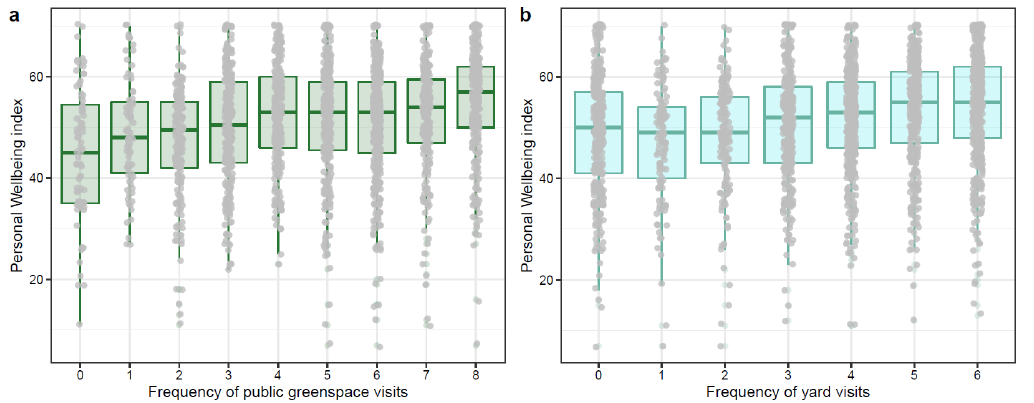
Figure 1. Differences in personal wellbeing based on the frequency of public green space and yard visit: People who visit public green space more often ( a ) or visit the yard more often ( b ) were more likely to have better personal wellbeing. Grey points are raw data points. In ( a ), 0 = never, 1 = once a year, 2 = once every three months, 3 = once a month, 4 = 2 – 3 times a month, 5 = once a week, 6 = 2 – 3 days a week, 7 = 3 – 5 days a week, and 8 = 6 – 7 days a week. In ( b ), 0 = without access to yard or never, 1 = less than once a month, 2 = 2 – 3 times a month, 3 = once a week, 4 = 2 – 3 days a week, 5 = 4 – 5 days a week, and 6 = 6 – 7 days a week. Additional analysis was run excluding individuals with- out access to a yard (Supplementary Table S2). 3.2. Green Space Use over the Year and Reported Change in Wellbeing We analysed the change in status wellbeing and health to better understand how changes in green space use were related to an increased likelihood of reporting positive or negative change in health and wellbeing over the year. We found that individuals who spent more time in green space compared to the previous year were more likely to expe- rience a positive change in their health and wellbeing, and they were also less likely to experience a negative change in their health and wellbeing (Table 2, Figure 2). Individuals who visited their yard more often compared to the previous year (Figure 2) or individuals with a higher nature orientation experienced a positive change in wellbeing (Table 2). Age was negatively correlated with positive and negative change in wellbeing over the year, meaning older individuals were less likely to report a change in wellbeing; while income was negatively correlated with a negative change in wellbeing over the year, meaning it was less likely for people with a higher income to have a negative change in wellbeing (Table 2). Table 2. Change in nature experience and change in health and wellbeing (positive and negative) over the first year of the COVID-19 pandemic, after controlling for demographic factors. Positive Change